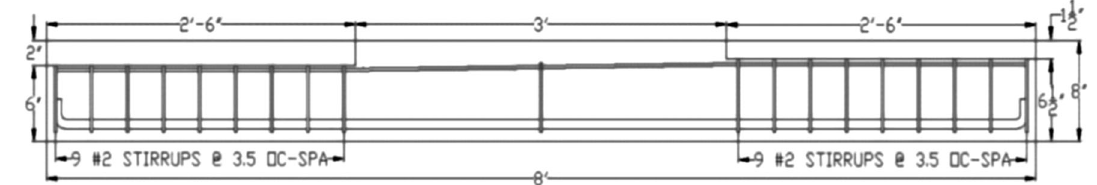
Fig. 7 Full-scale beam elevation dimensions.